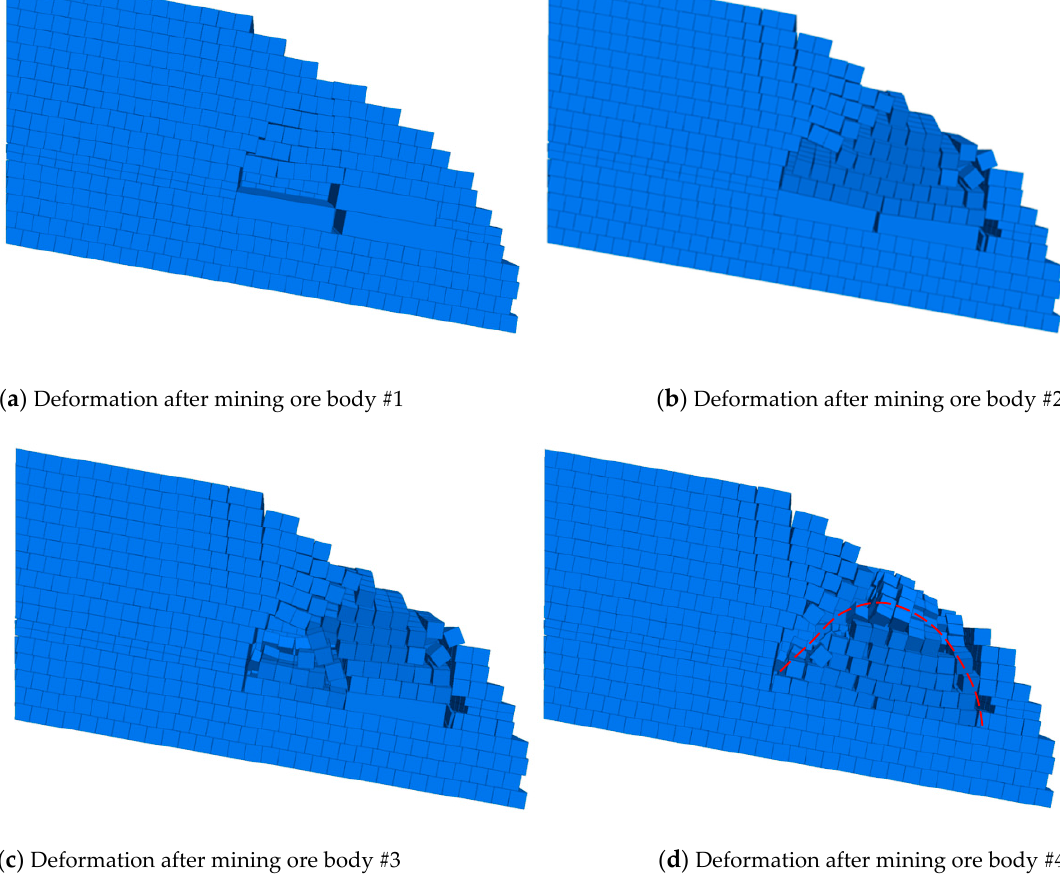
Figure 14. Process of strata movement by numerical simulation